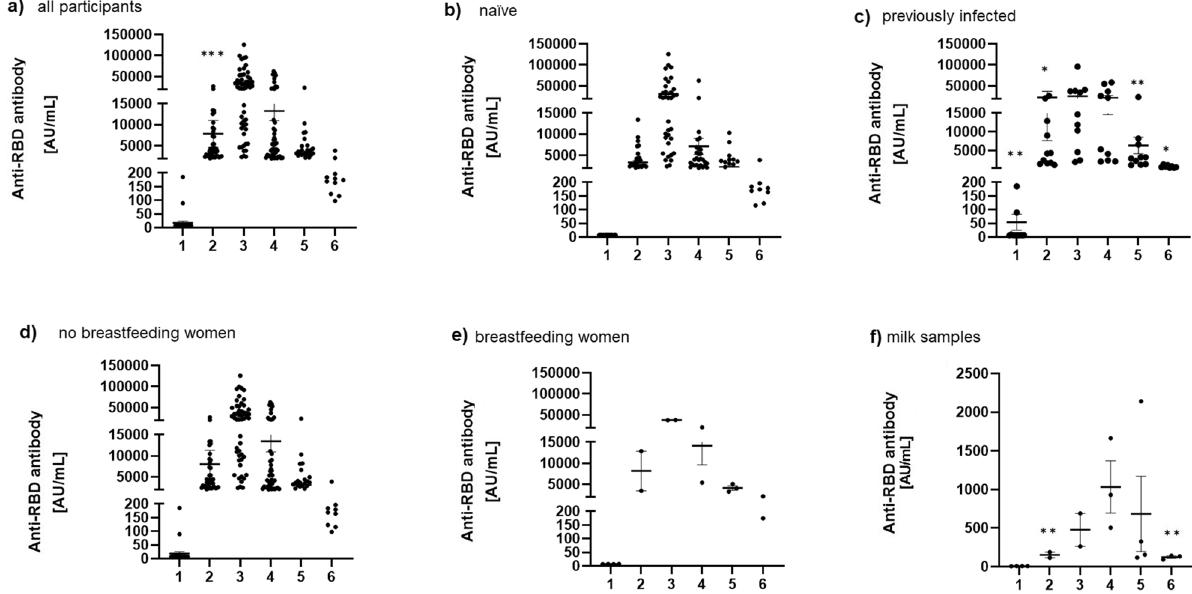
Figure 1. Serum anti-RBD IgG antibody levels in the ( a ) whole analyzed group, ( b naïve, c ) previously infected individuals, ( d ) whole group without breastfeeding women, ( e ) breastfeeding women and ( f ) in the milk of breastfeeding women. The results are presented as individual values with mean ± standard error of the mean (SEM) of three independent replicates. Differences between values were compared using unpaired t-test and the results were considered statistically significant if p < 0.05. * p < 0.05; ** p < 0.01; *** p <